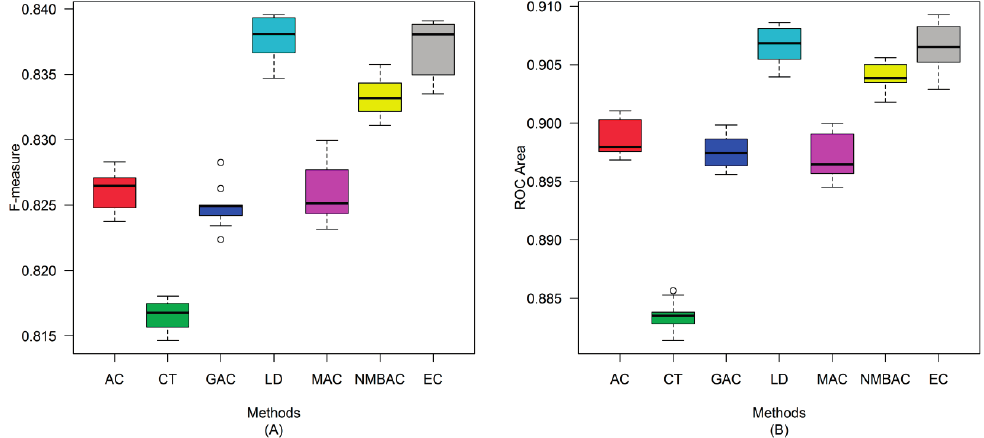
Figure 18. Average F-measure and ROC area of different methods on the Silver Human dataset with five-fold cross-validation. ( A ) F-measure; ( B ) ROC